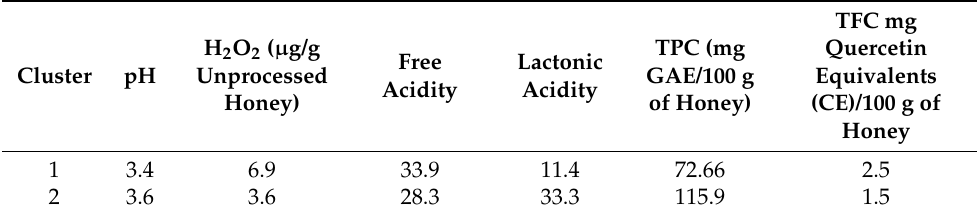
Table 5. Centroids of the 2 clusters formed by the physicochemical analysis of the 20 Satureja spp. honey